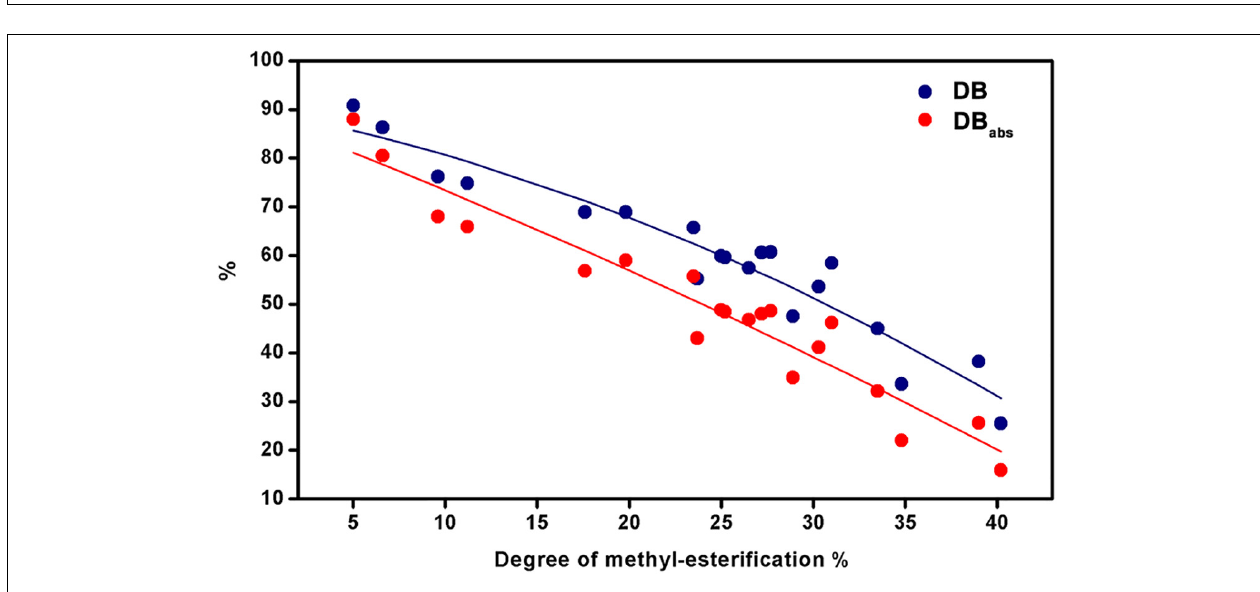
FIGURE 9 | DB and DB abs as a function of the degree of methylesterification for the 20 HG pectins.